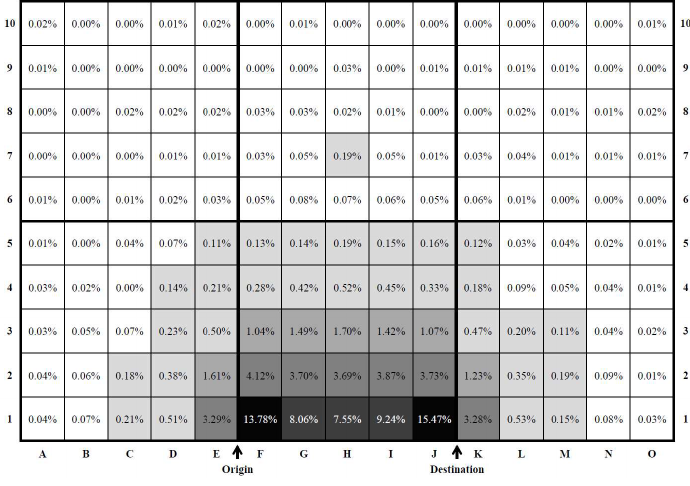
Figure 6. Cell-density in respective clusters.